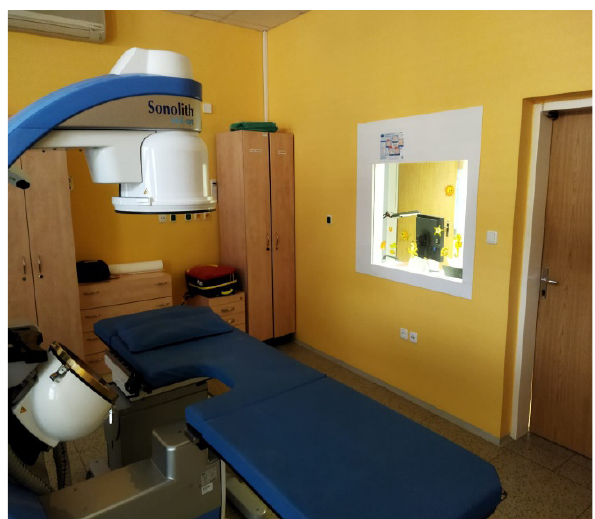
Fig. 2. Remote - control station.